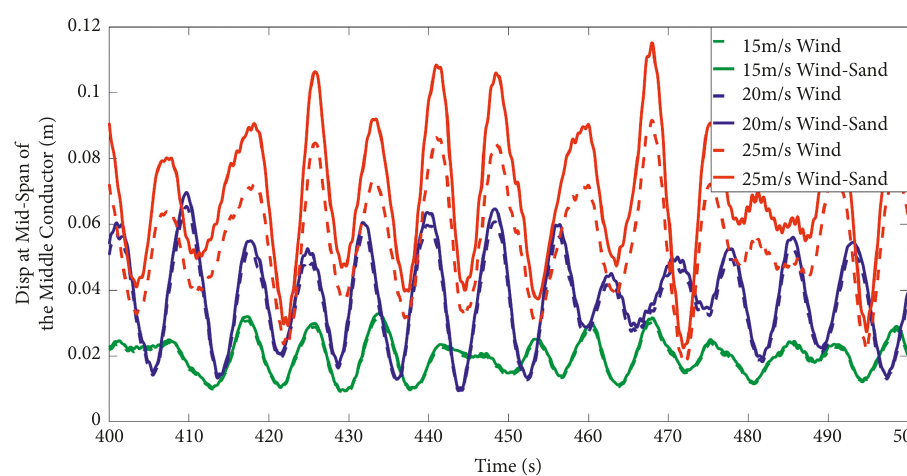
Figure 9: Displacement at the mid-span of the middle